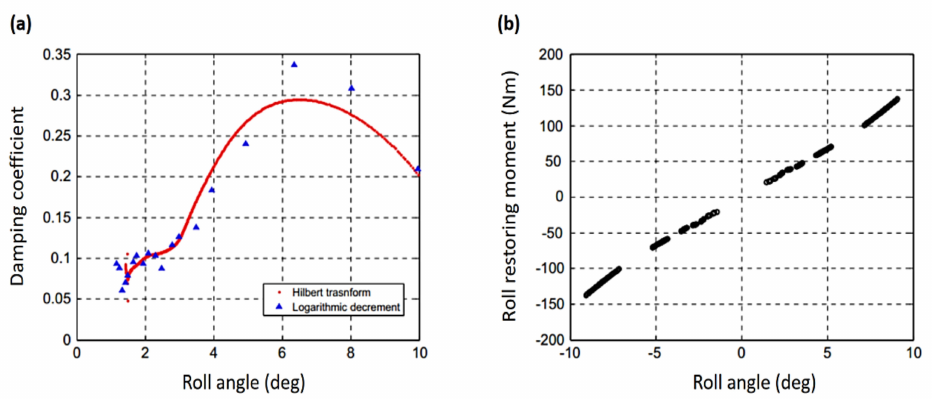
Figure 10. The floating production storage and o ffl oading identified dynamic parameters with respect to the roll angle. ( a ) Damping coe ffi cient; ( b ) restoring moment [114].